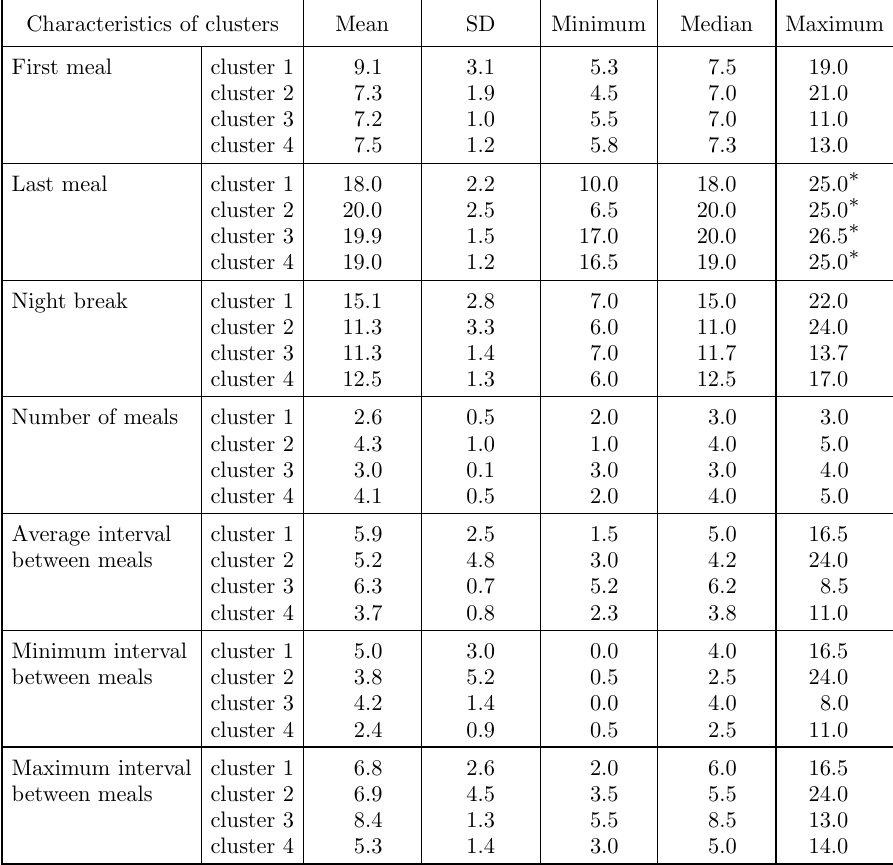
Table 2. Characteristics of clusters with respect to the number of meals during the day and the time of consumption Characteristics of